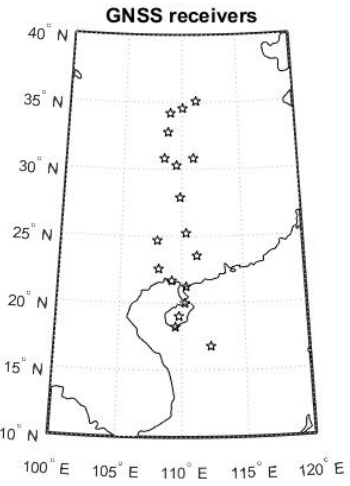
Figure 1. Geographical location of all 18 GNSS receivers (described in the text) in the 100° E to 120° E and 10° N to 40° N sector.